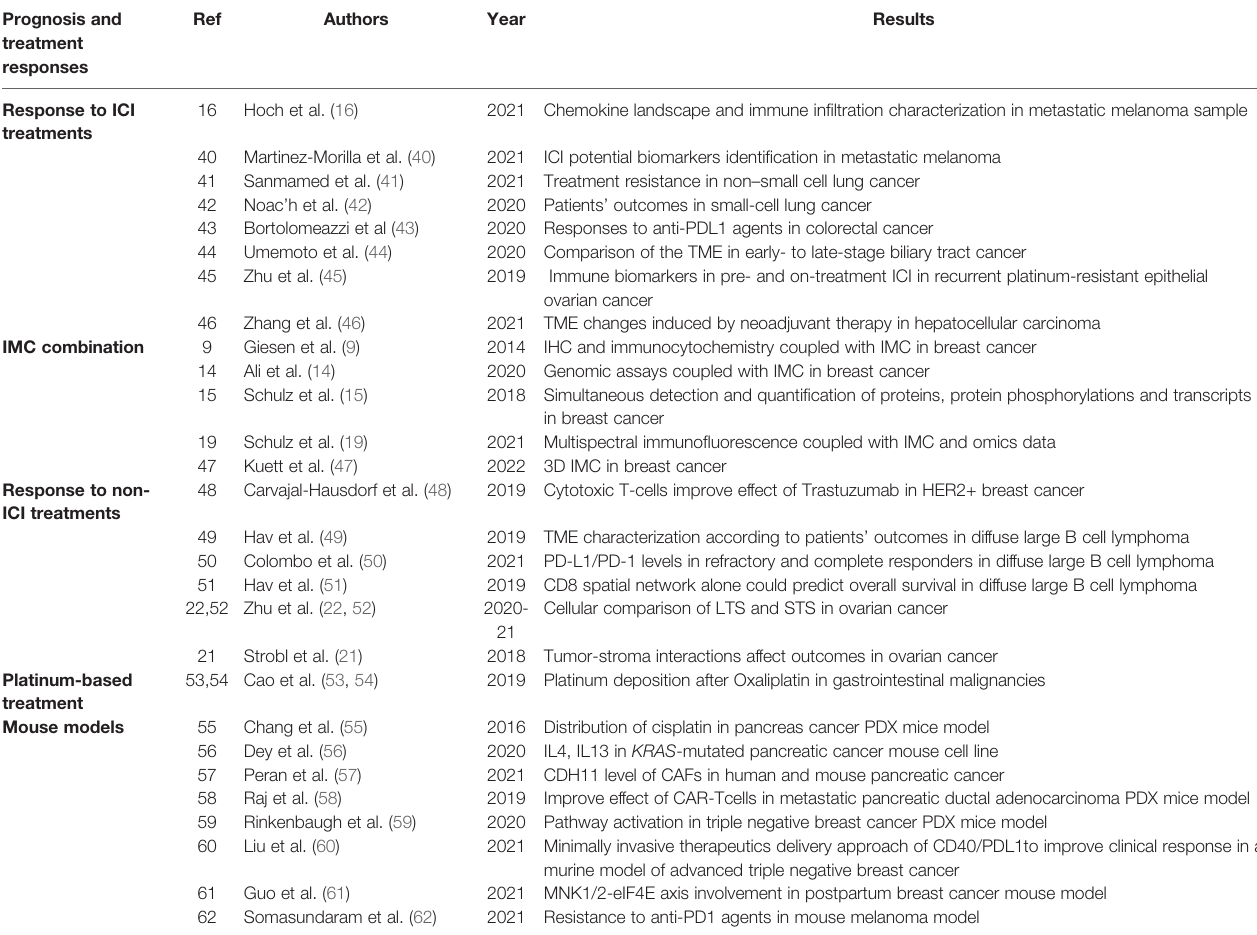
TABLE 2 | Summary table of studies on patients ’ prognosis and treatment responses using IMC technology in human and mouse cancerous